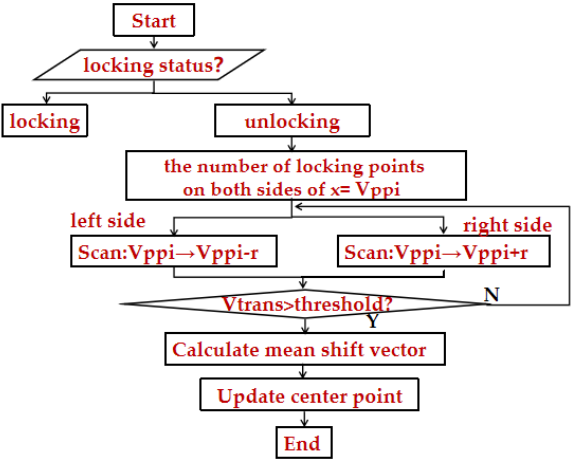
Figure 4. Scanning process for the transmission